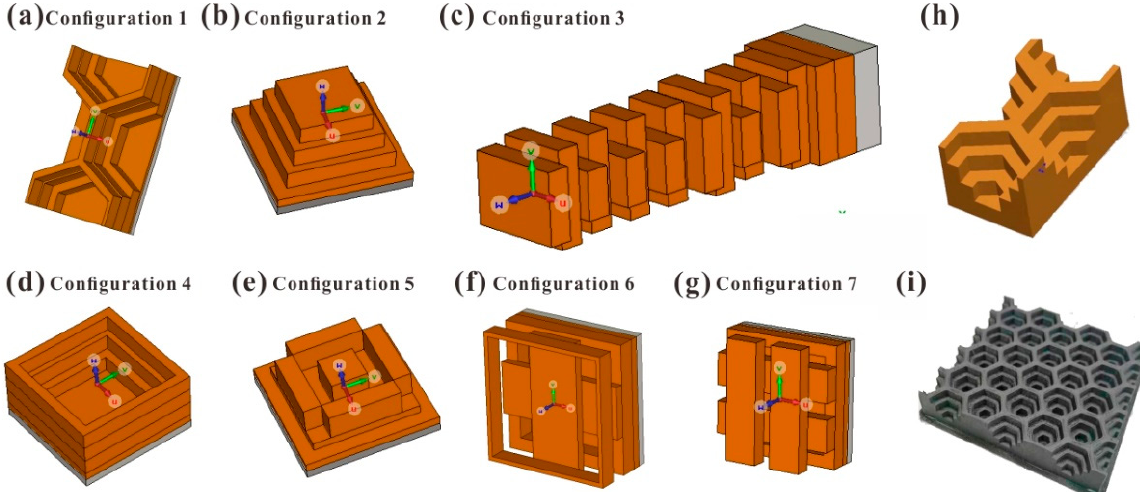
Figure 1. Experimental complex permittivity and complex permeability of CI/MWCNT/PLA hy- brid material at 2–40 GHz.